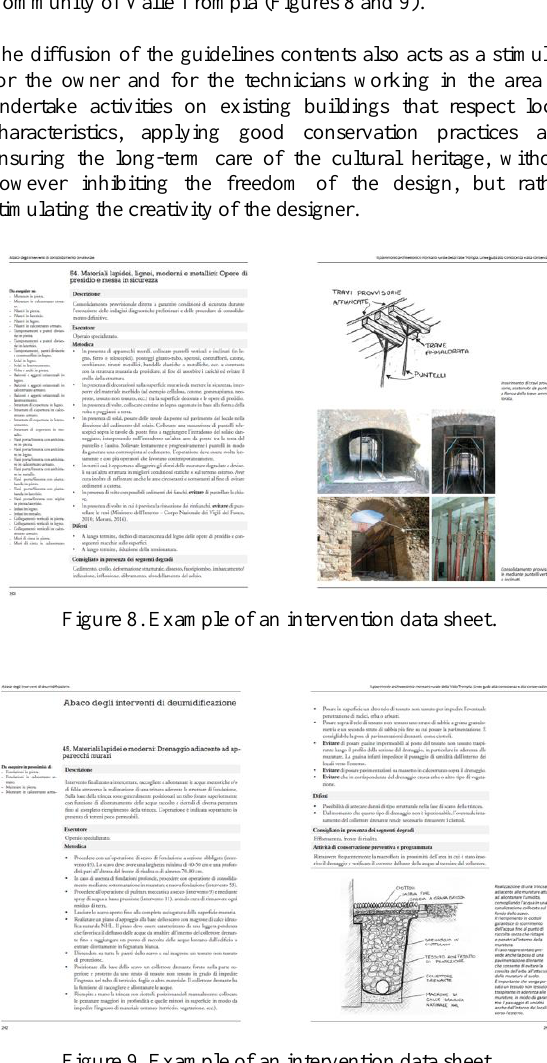
Figure 9. Example of an intervention data